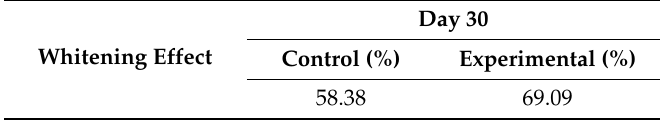
Table 7. Average whitening effect of 20 subjects using the butterfly pea flower hot spring water